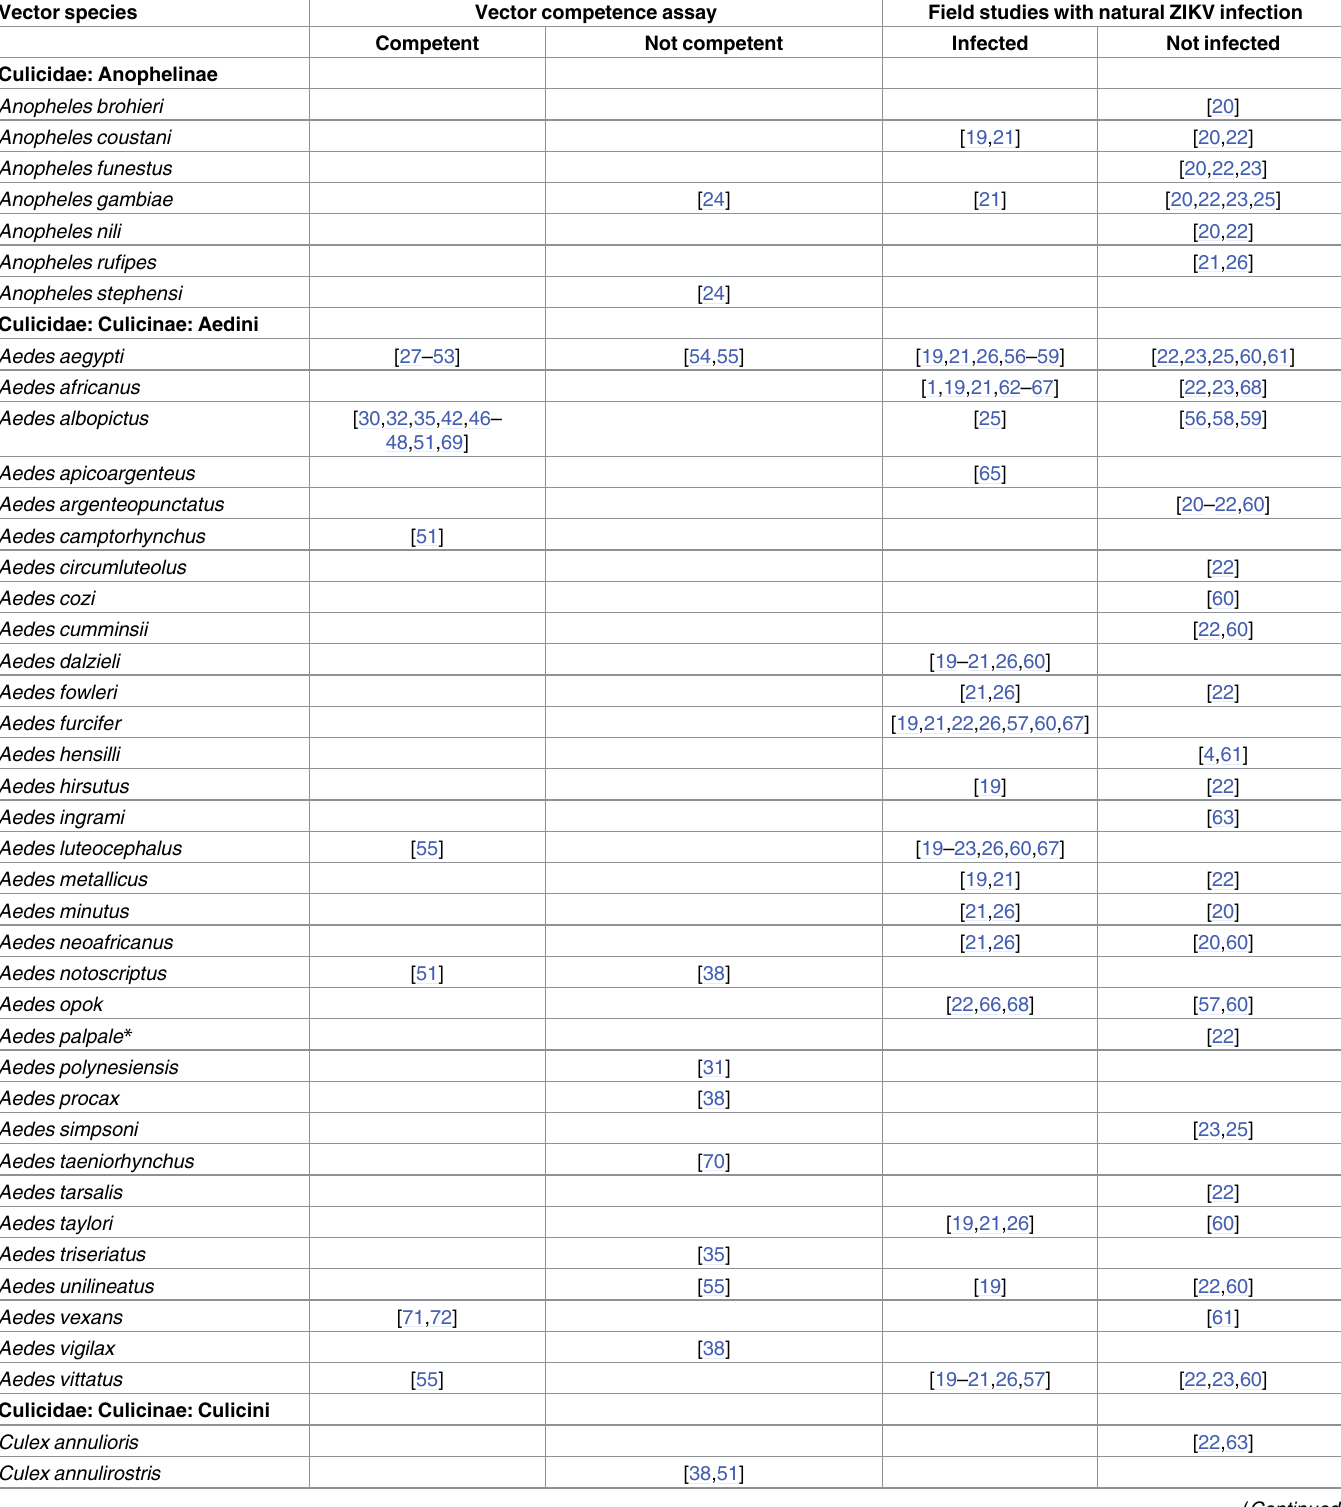
Table 1. Vector species naturally infected by ZIKV or studied experimentally for their ZIKV